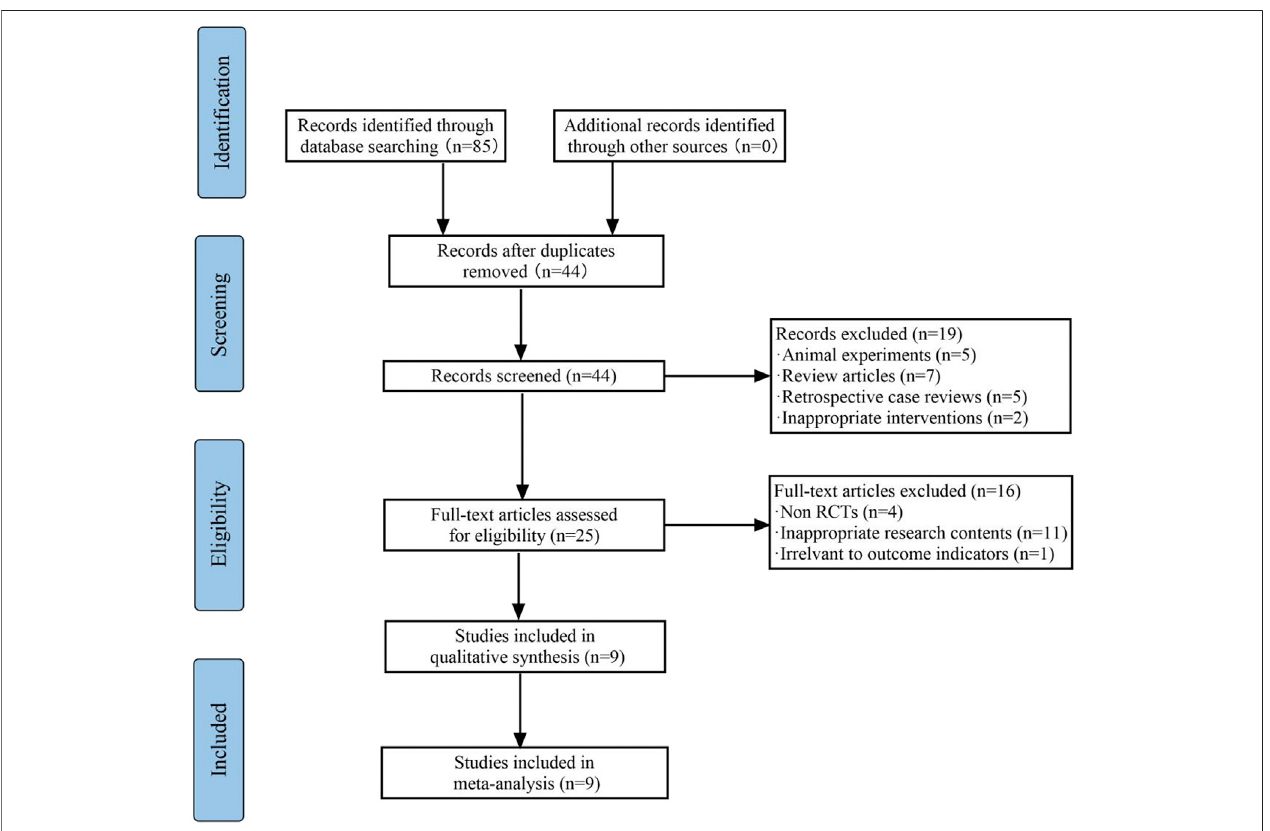
FIGURE 1 | PRISMA fl ow diagram of the literature search